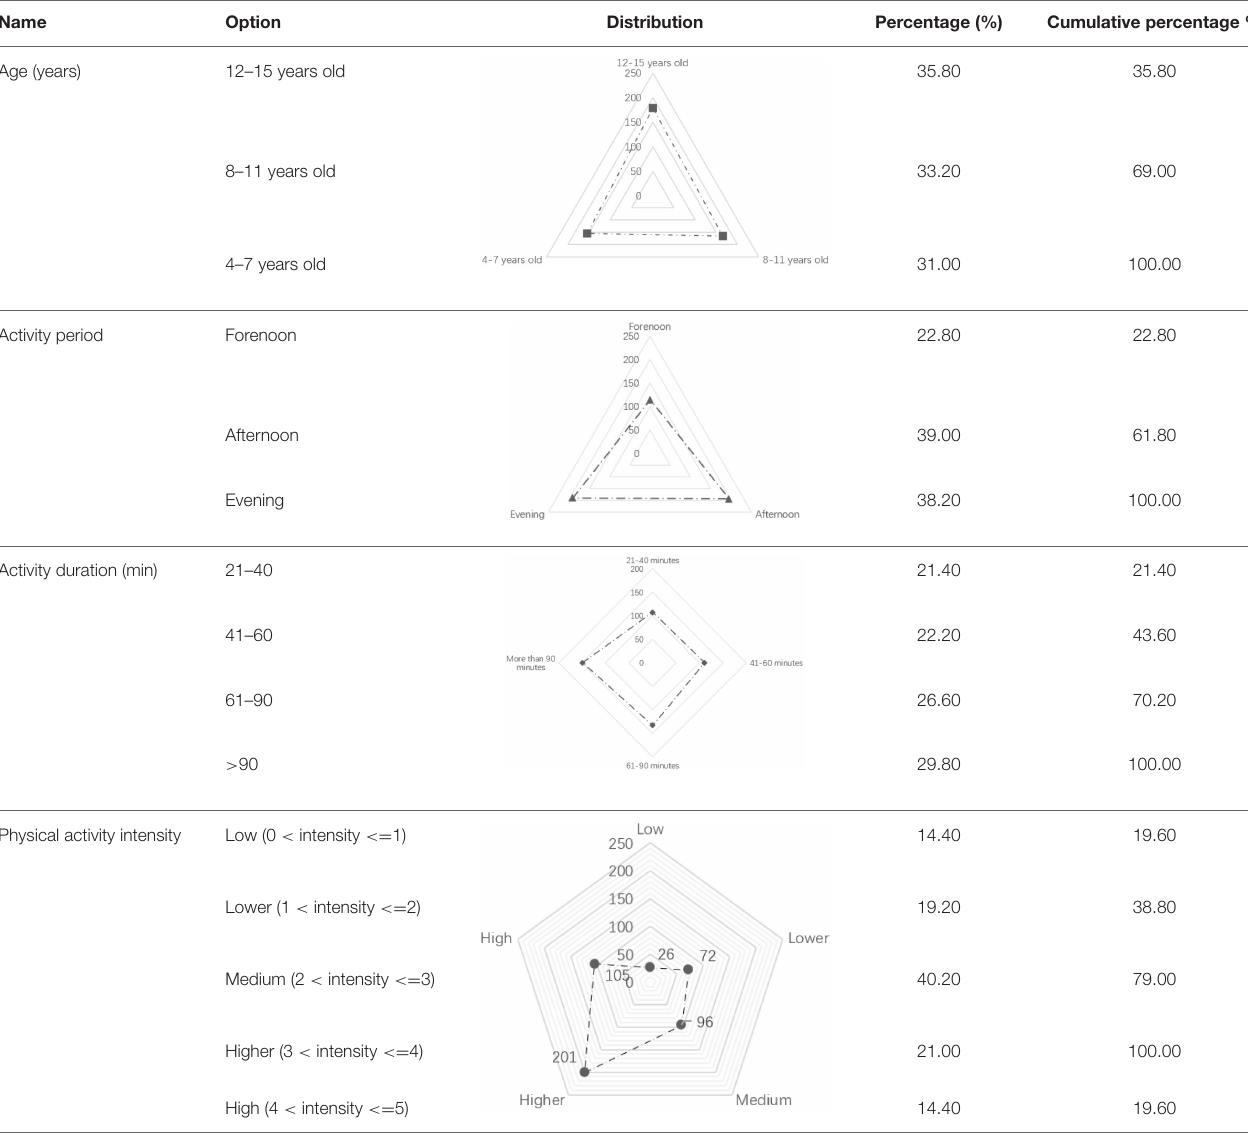
TABLE 2 | Analysis of children’s age, activity period, activity duration, and